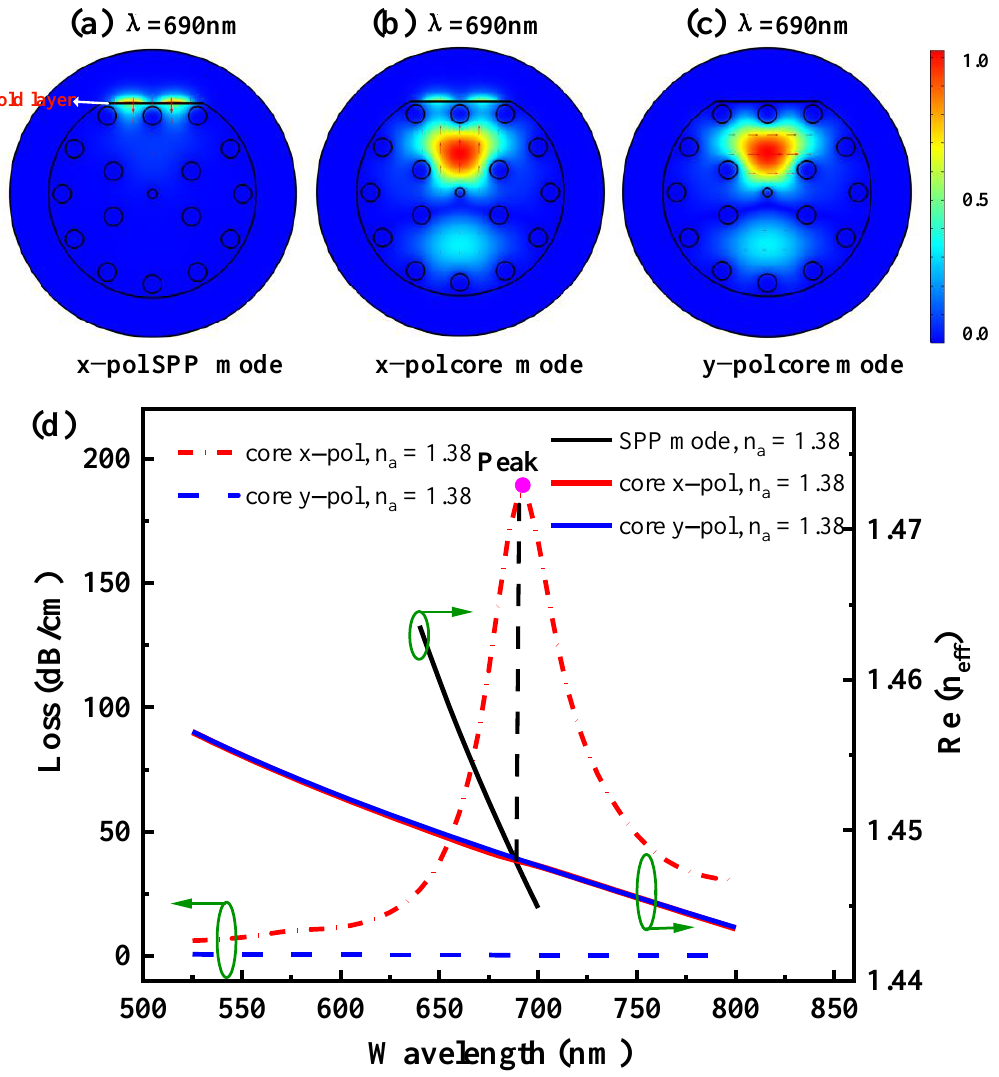
Figure 3. Mode field distribution of fundamental ( a ) x-pol surface plasmon polariton (SPP) mode, ( b ) x-pol core mode, and ( c ) y-pol core mode at 685 nm. ( d ) Relation of dispersion between the fundamental core-guided mode and SPP mode with n a = 1.38, t g = 40 nm, and L G = 0.